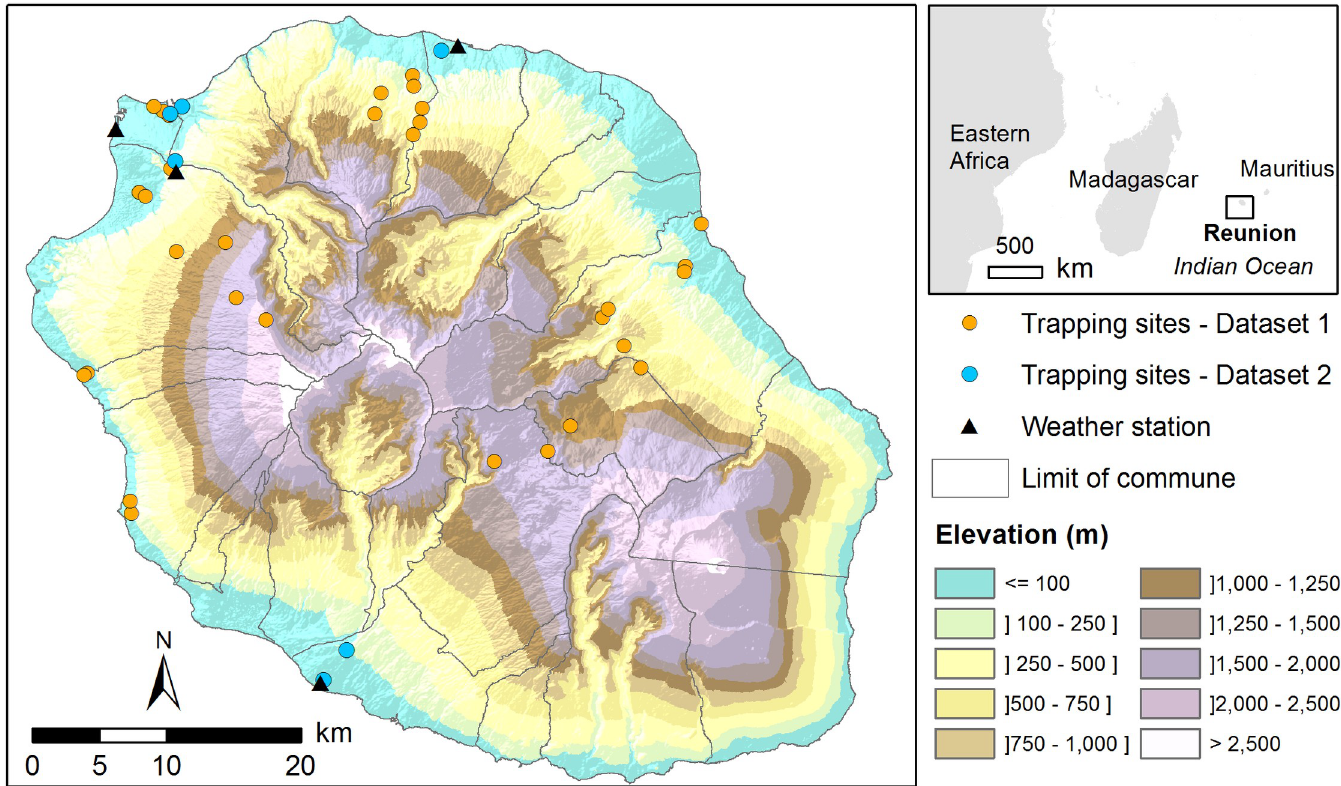
Fig 1. Location of the study area. The map shows the relief of Reunion Island (source: French national geographic institute, BD ALTI–data available under the free license Open license 2.0) as well as sampling sites for each dataset and the location of the weather stations used for modelling.